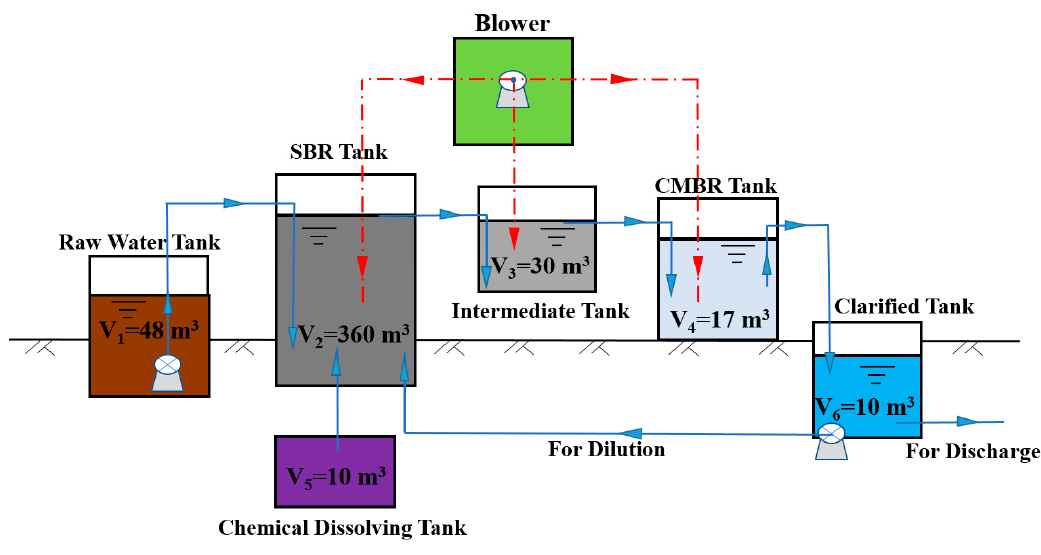
Figure 1. Process flow diagram.